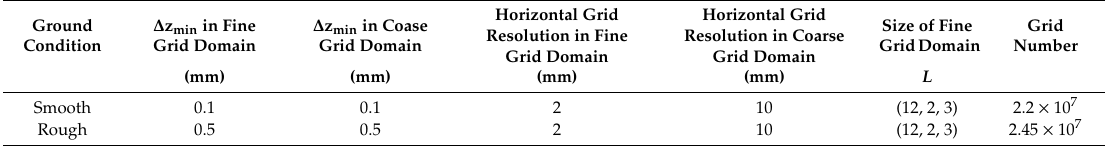
Table 3. Parameters of the grid